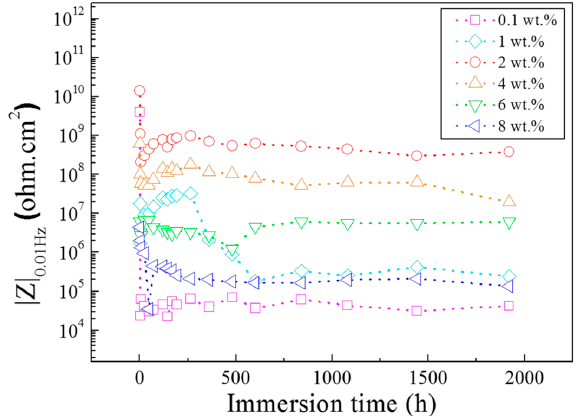
Figure 2. Evolution of |Z| 0.01Hz with immersion time in 3.5% NaCl solution for the coating/aluminum system.